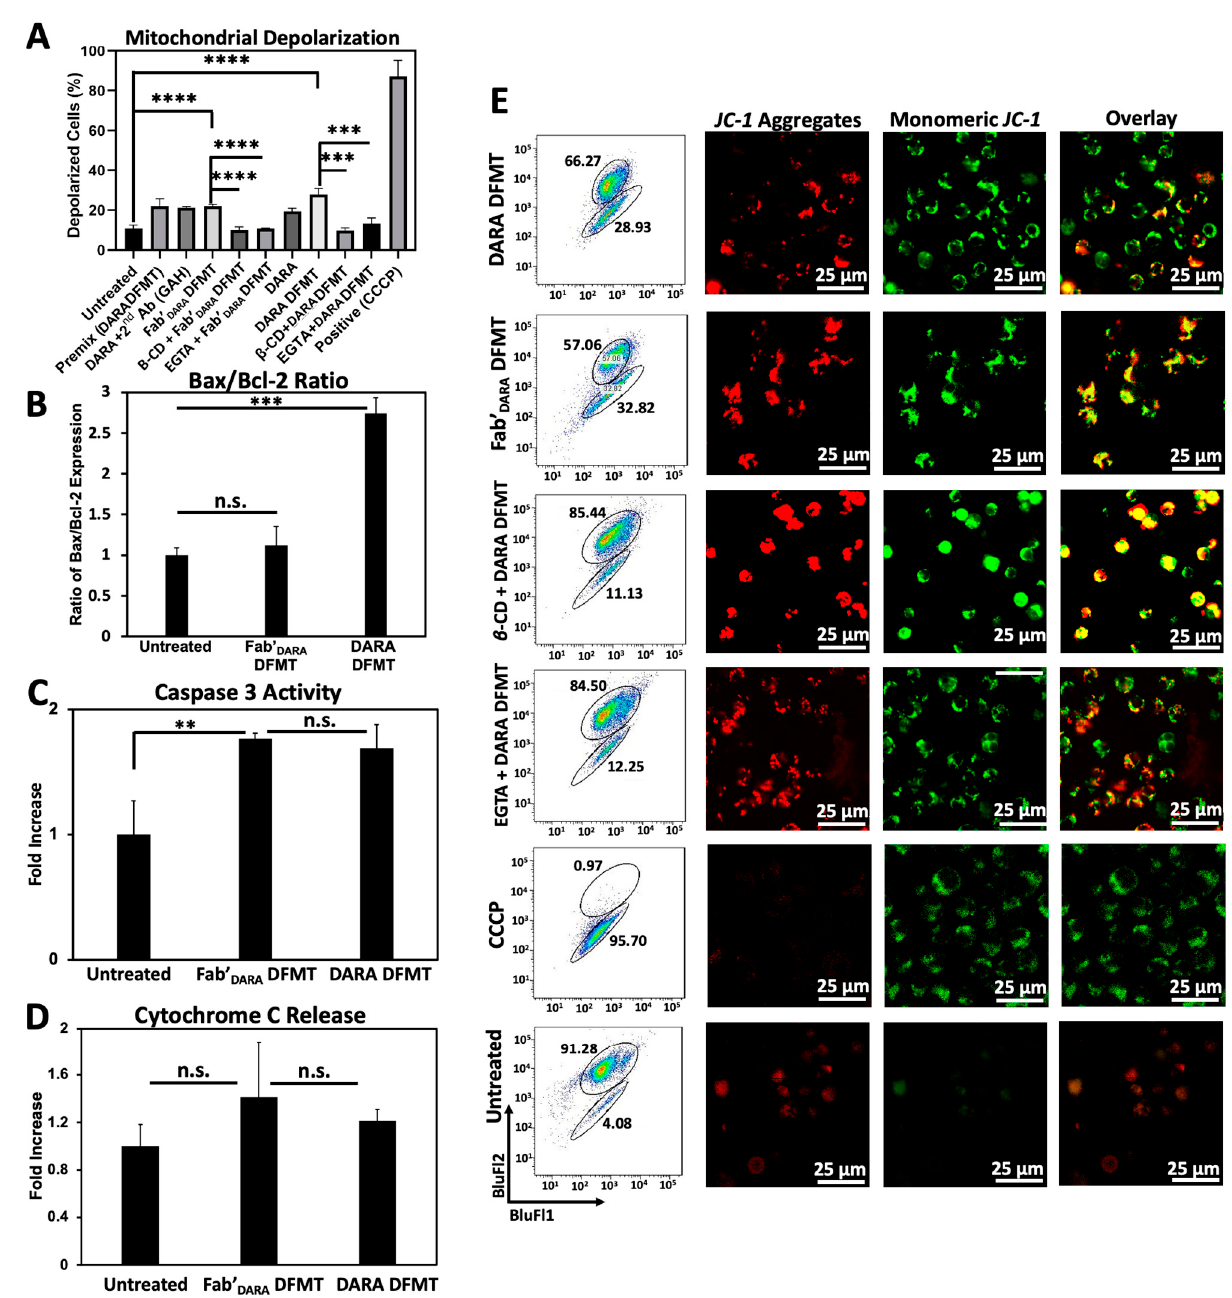
Figure 4. Investigation of mitochondrial pathway involvement in apoptosis induction in Daudi cells. ( A ) Compiled mitochondrial membrane depolarization of DARA DFMT and Fab’ DARA DFMT treated Daudi cells with or without the presence of inhibitors (EGTA or β -CD). Controls include untreated cells, a DARA-based DFMT “Premix” group, DARA crosslinked with a secondary antibody (goat antihuman: GAH), and a positive control treatment with CCCP. Depolarization was measured by JC-1 red/green fluorescence by flow cytometry. ( B ) Bax/Bcl-2 expression ratio of DARA-based DFMT and Fab’ DARA -based DFMT treated Daudi cells. Expression was measured using immunostaining and flow cytometry. ( C ) Caspase 3 activity of DARA DFMT and Fab’ DARA DFMT treated Daudi cells was measured using PhiPhiLux ® assay kit and flow cytometry. ( D ) Cytochrome C release of DARA and Fab’ DARA DFMT on Daudi cells. Increase in Cytochrome C release shown as fold increase over untreated cells. Determined by ELISA. ( E ) Confocal fluorescence microscopy visualization of mitochondrial depolarization of DARA DFMT with or without the presence of EGTA or β -CD. More red fluorescence indicates healthier mitochondria while more green fluorescence indicates the occurrence of depolarization. **** p < 0.0001, *** p < 0.001, ** p < 0.01, n.s. nonsignificant, by One-Way ANOVA and Tukey